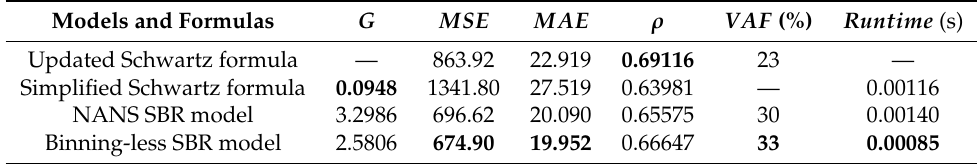
Table 3. Modeling pedriatic patients’ GFR data: Generalization/roughness index ( G ), mean squared error ( MSE ), mean absolute error ( MAE ) and coefficient of correlation ( ρ ) for the four considered estimation models (updated Schwartz formula, simplified Schwartz formula independent of height, numerical-algebraic neural-system based statistical bivariate numerical modeling algorithm, and proposed statistical bivariate numerical modeling algorithm). Highlighted values denote best